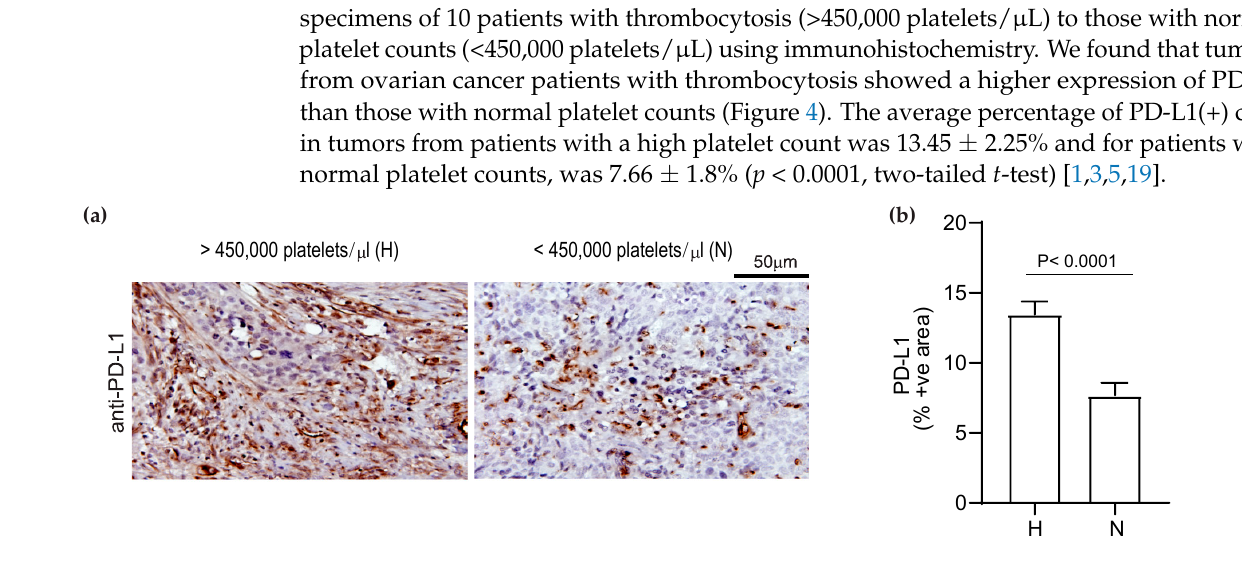
Figure 4. Thrombocytosis is associated with increased PD-L1 expression in human ovarian cancer tumors. ( a ) Representative immunostaining of a tumor specimen resected from a patient with thrombocytosis (platelet counts > 450,000/µL, n = 10 patients) and a patient with normal platelet counts (<450,000/µL, n = 10 patients) for PD-L1. ( b ) The comparison of expression of PD-L1 in patients with thrombocytosis ( n = 10 patients) compared to those with normal platelet counts ( n = 10 patients). The expression of PD-L1 was detected by immunostaining the tumor slides for PD-L1 and quantified using ImageJ software. The results are shown as the percentage of PD-L1-positive area. The statistical significance was calculated using a two-tailed t -test.